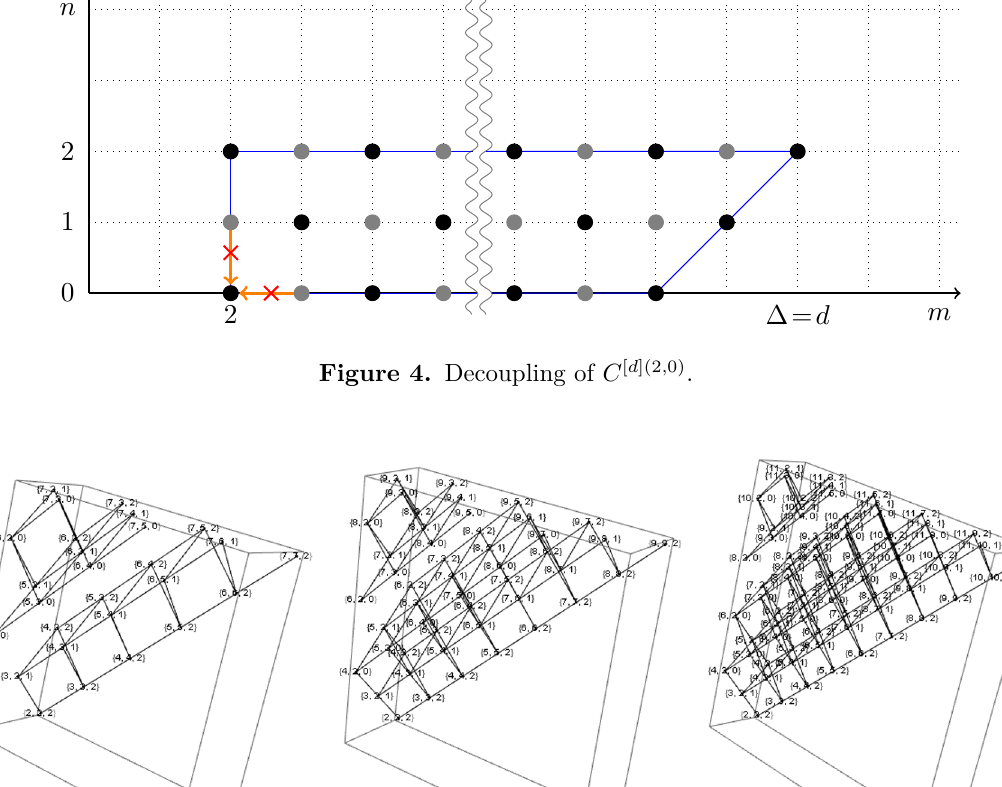
For a generic ‘ , the black bullets, which have vanishing k [∆ − 1] m,n